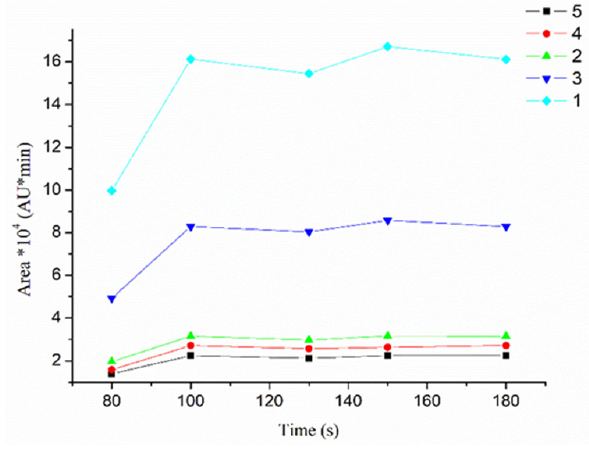
Figure 5. Effect of injection time on peak area of five compounds. LVSS-MEKC inject: 0.5 psi, negative 30 kV, 0.5 min. The concentrations of analytes: 0.5 µ g/mL. Other conditions are the same as Figure 4.